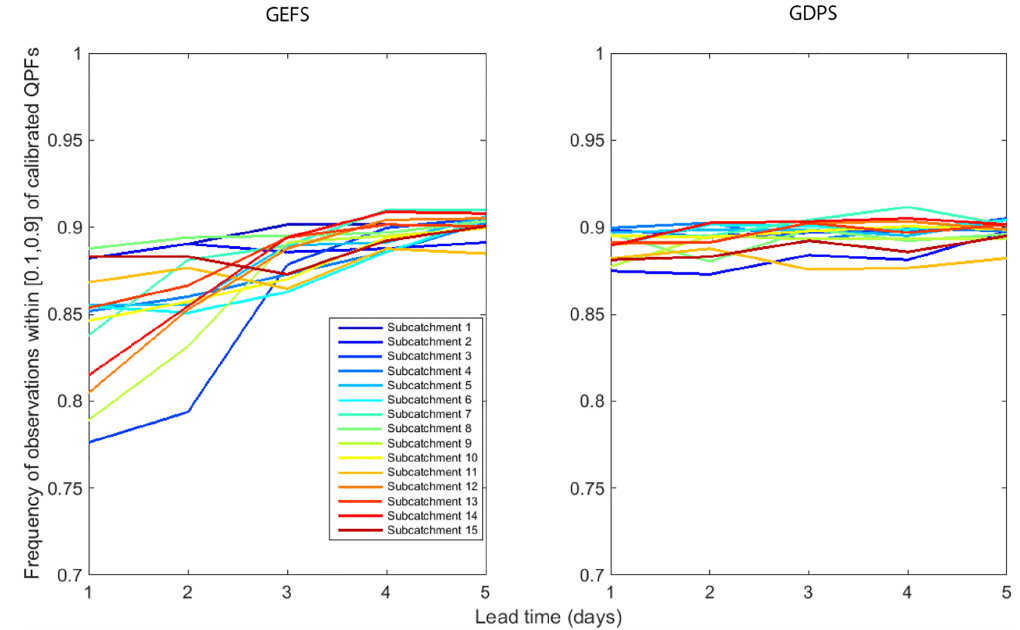
Figure 6. Frequency of observations lying within the 10th and 90th percentile of calibrated GEFS and calibrated